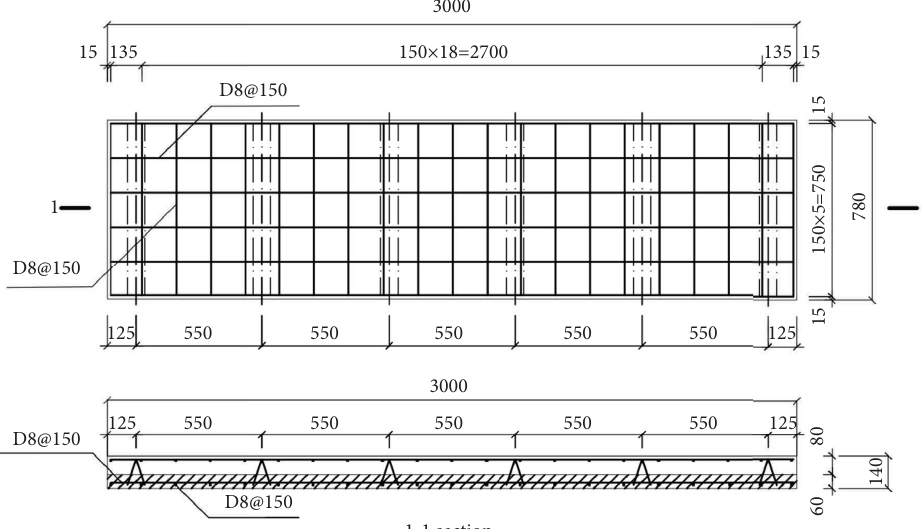
Figure 3: Reinforcement details of